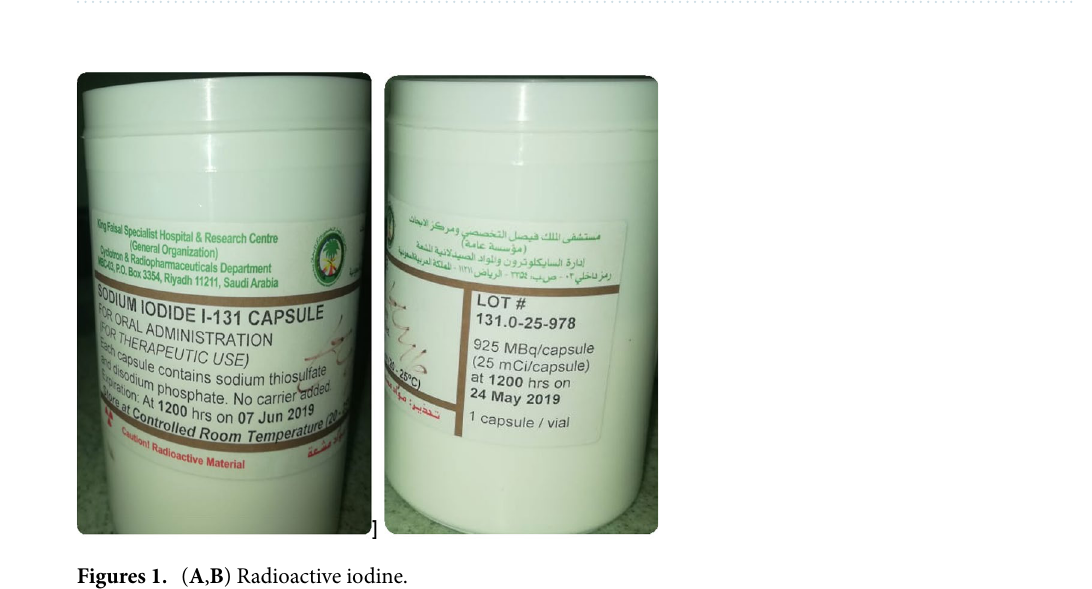
Table 2. Mean, ± Sd and range of patient demographic data in hyperthyroidism by using